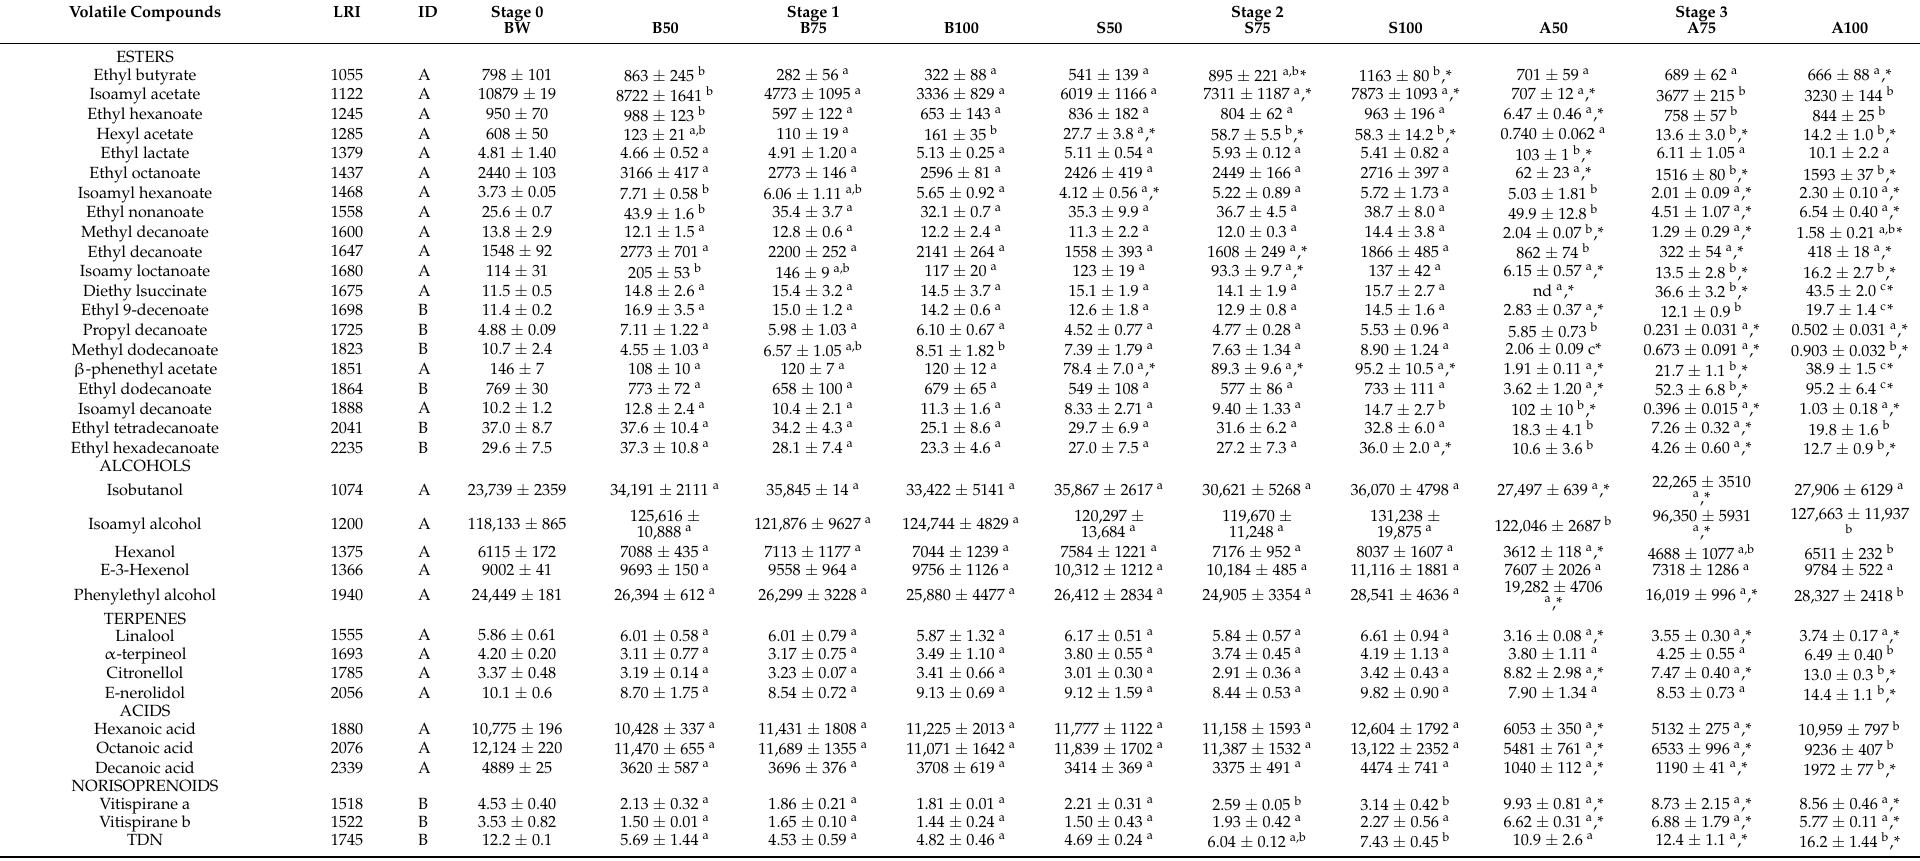
Table 1. Concentration of volatile compounds of Chardonnay base and sparkling wines along the production